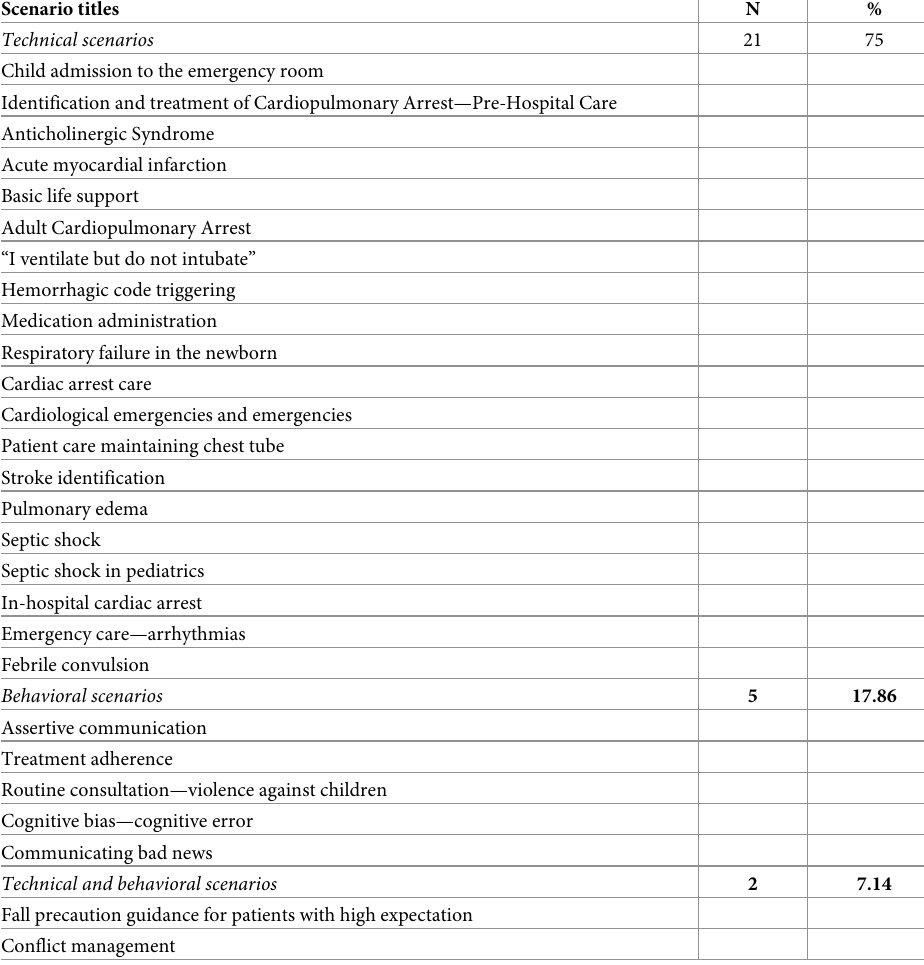
Table 7. Titles of the scenarios developed by the participants (n = 28). Sao Paulo, SP, Brazil,